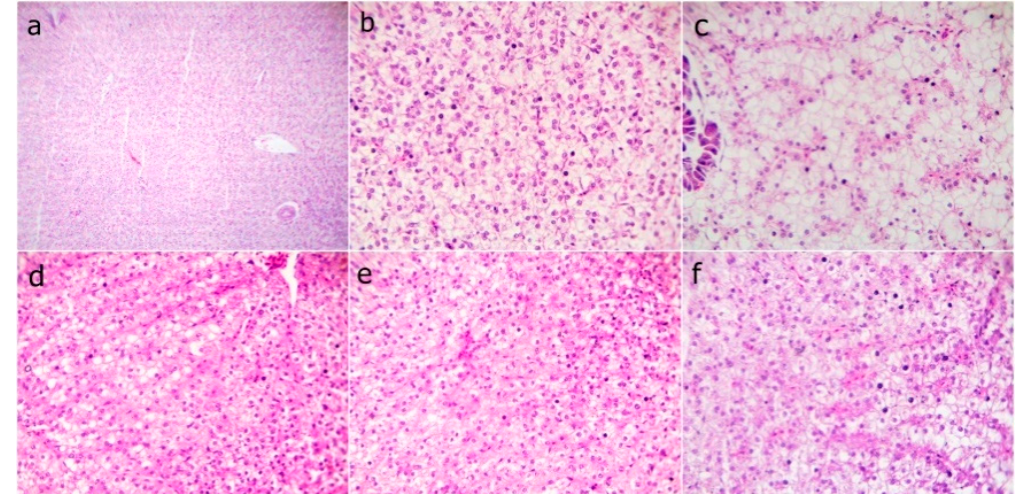
Figure 4. Representative photomicrograph of H&E stained sections from fish liver before the bacterial challenge showing ( a ) WPC0—at low 40x and ( b ) WPC0—high magnification 400x of the normal